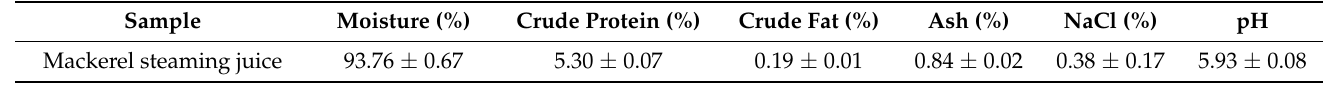
Table 1. Proximate composition, NaCl content and pH of mackerel steaming juice (MSJ). Sample Moisture (%) Crude Protein (%) Crude Fat (%) Ash (%) Mackerel steaming